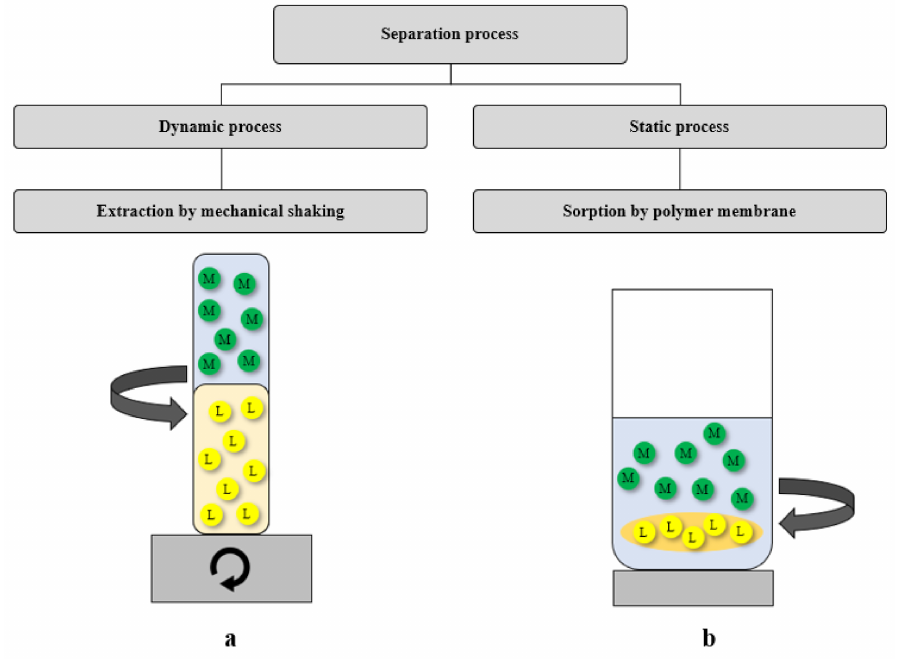
Figure 8. Scheme of the dynamic and static extraction processes, where L —2,6-bis(4-methoxybenzoyl)- diaminopyridine; ( a ) dissolved in the organic phase, ( b ) contained in a polymer membrane; M = Au(III), Ag(I), Pd(II) or Pt(II) ions in the aqueous